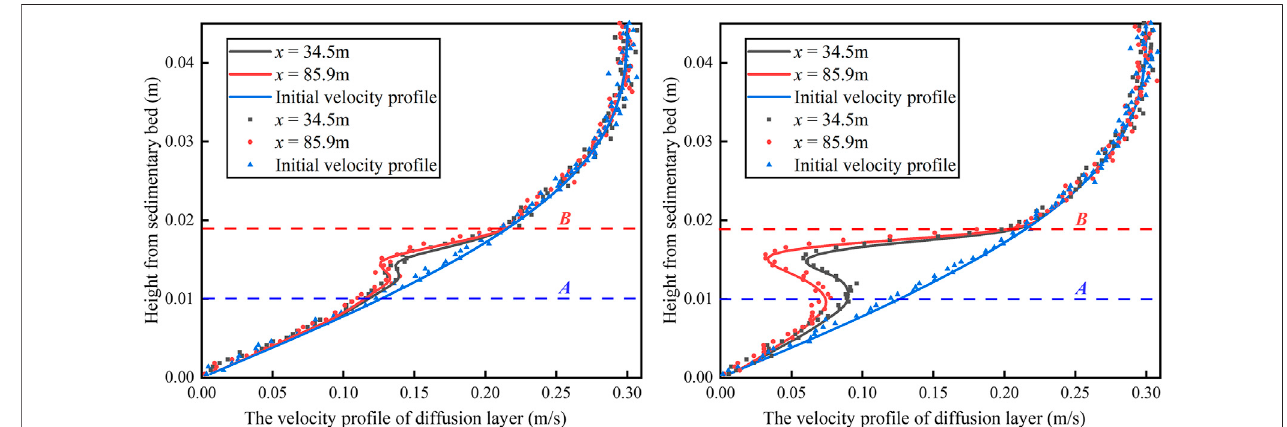
FIGURE 10 | Comparison of experimental and model calculation data of slurry velocity distribution.